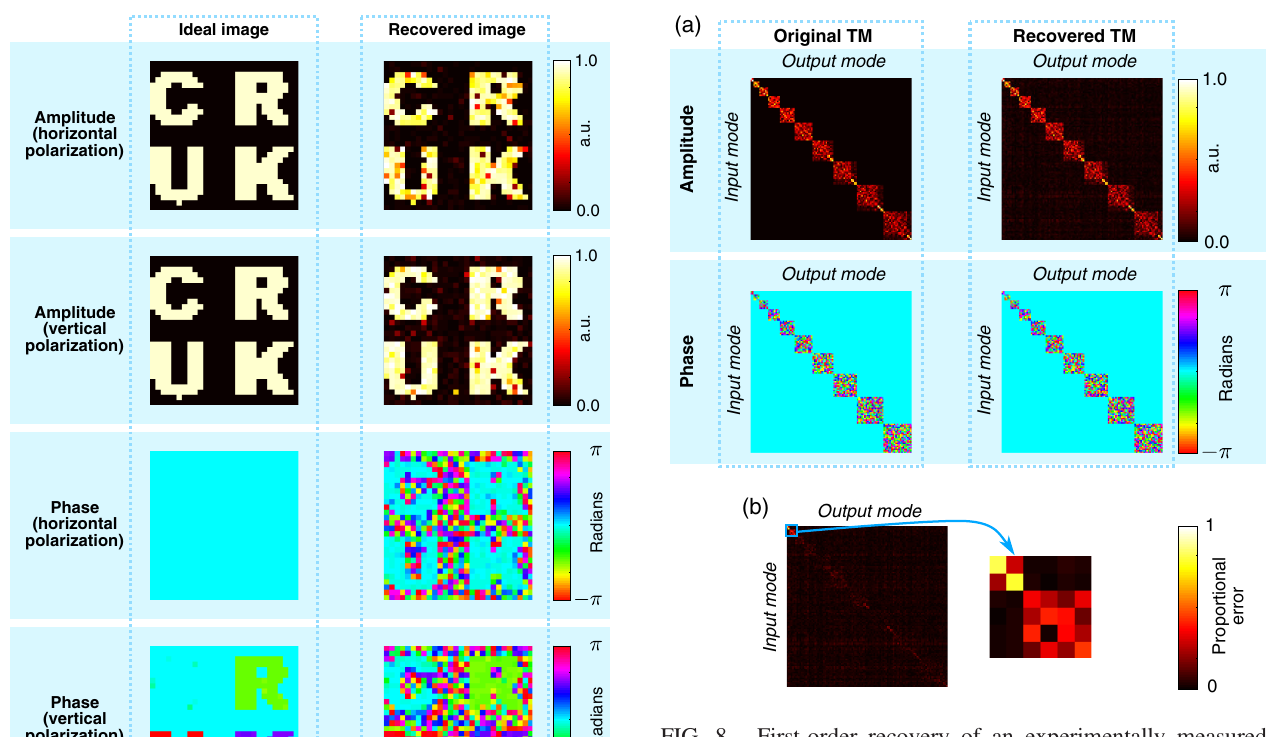
FIG. 8. First-order recovery of an experimentally measured, step-index MMF TM, using TMs recorded at multiple wave- lengths (1525.6 nm, 1526.5 nm, 1527.4 nm, and 1528.3 nm) [26]. (a) Original TM using data from Ref. [26] and the first-order recovered TM, showing high visual similarity, which indicates successful recovery. (b) Proportional elementwise error in TM reconstruction values typically less than 0.05 except for the very lowest-order modes that exhibit an error of about 0.2 due to phase